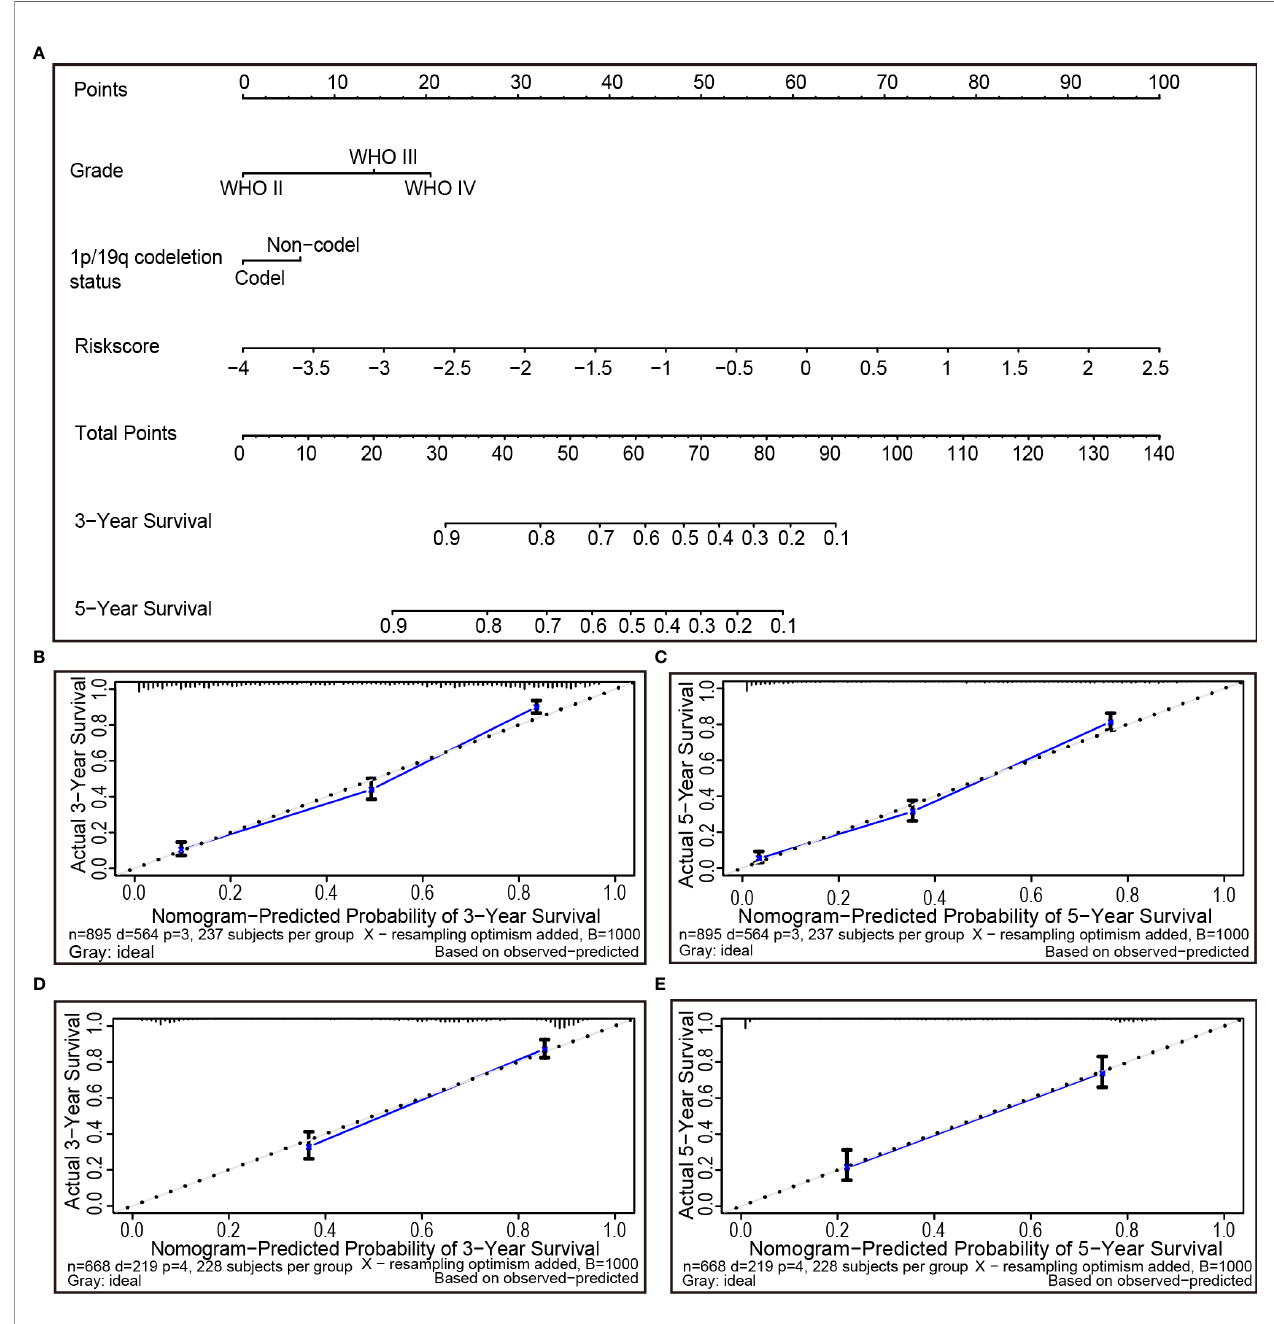
FIGURE 7 | The nomogram can predict the prognosis probability in gliomas. (A) A nomogram of the gliomas cohort (training set) used to predict the overall survival. (B, C) Calibration maps used to predict the 3-year (B) and 5-year survival (C) in the training set. Calibration plots for 3-year (D) and 5-year survival (E) in the TCGA cohort (test group). The x-axis and y-axis represent the predicted and actual survival rates of the nomogram, respectively. The solid line represents the predicted nomogram, and the vertical line represents the 95% con fi dence